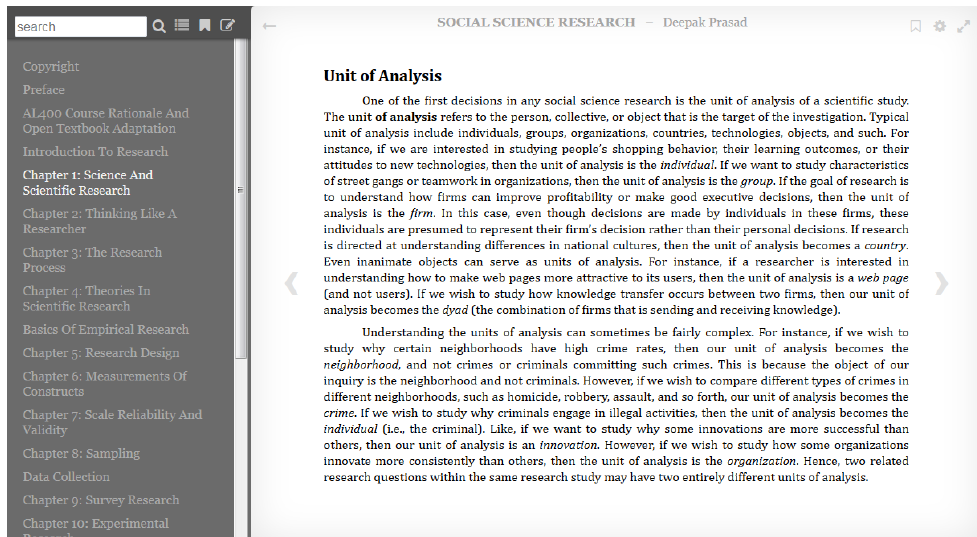
Figure 2. Customized EPUB.js reader user